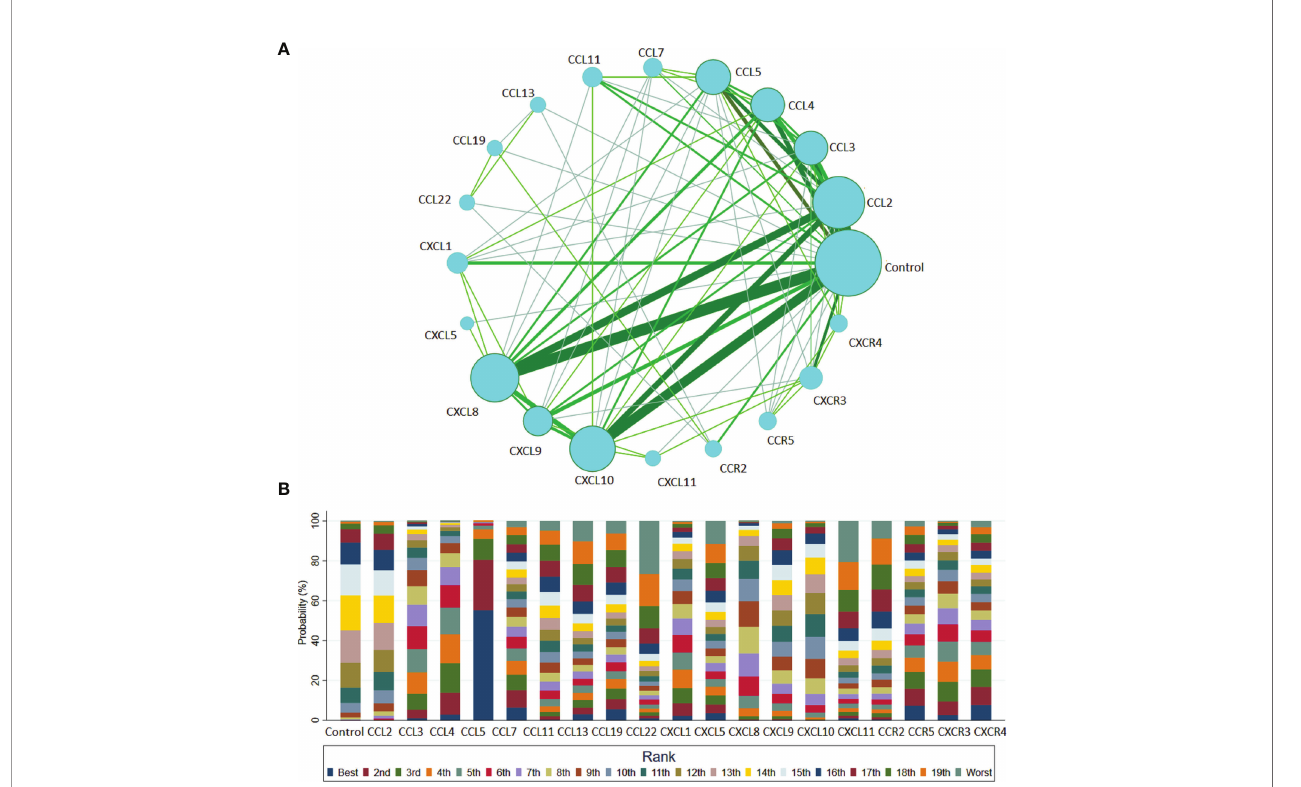
FIGURE 3 | Network meta-analysis of chemokines comparisons for T1DM (A) and rank probability of chemokines in T1DM group for response rate in the network analysis (B) . The width of lines is proportional to the number of studies comparing every pair of chemokines. The size of each circle is proportional to the sample size (i.e., number of participants). (A) This plot shows the relative cumulative probabilities for each of the chemokines in the network. SUCRA values are presented in the legend. SUCRA, surface under cumulative ranking curve (B)